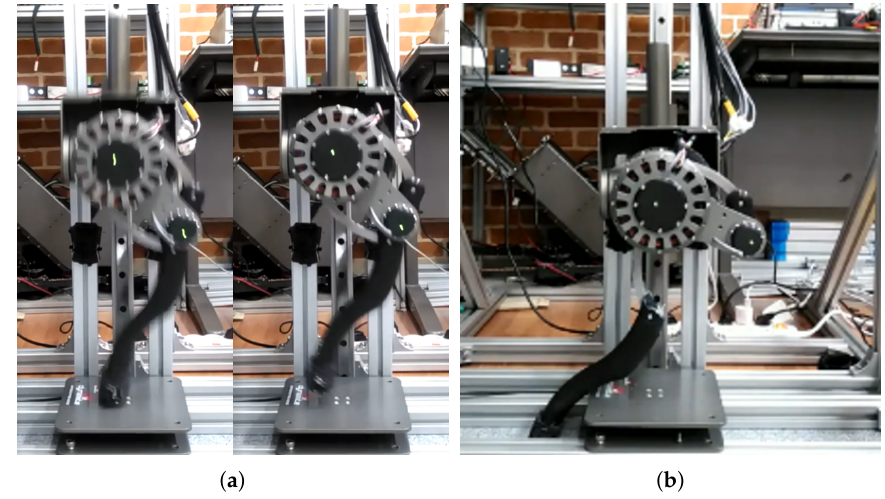
Figure 1. Effect of sudden impact: ( a ) contact loss; ( b )